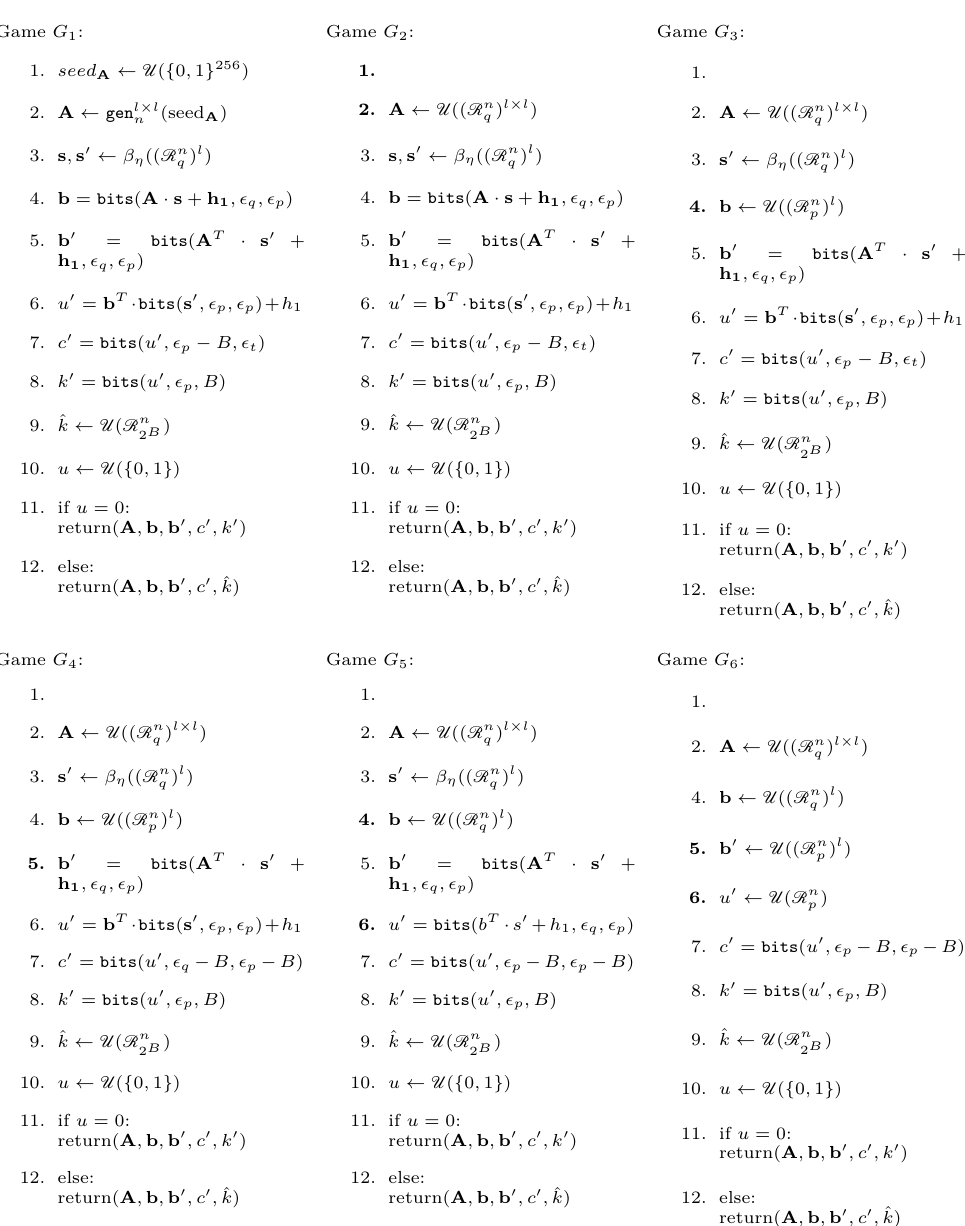
Figure 6: Sequence of games that are used in the proof of Theorem